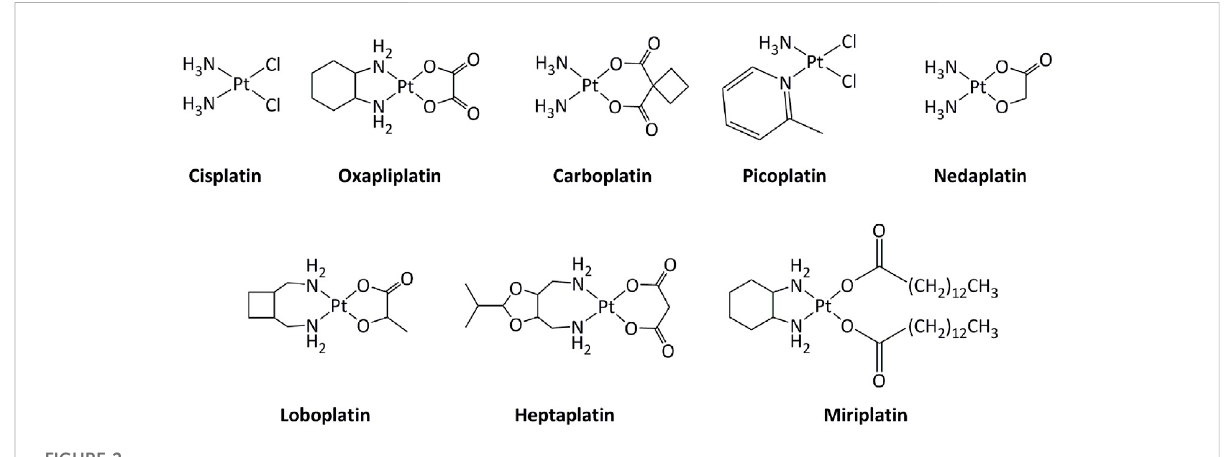
FIGURE 2 Platinum complexes used as anticancer